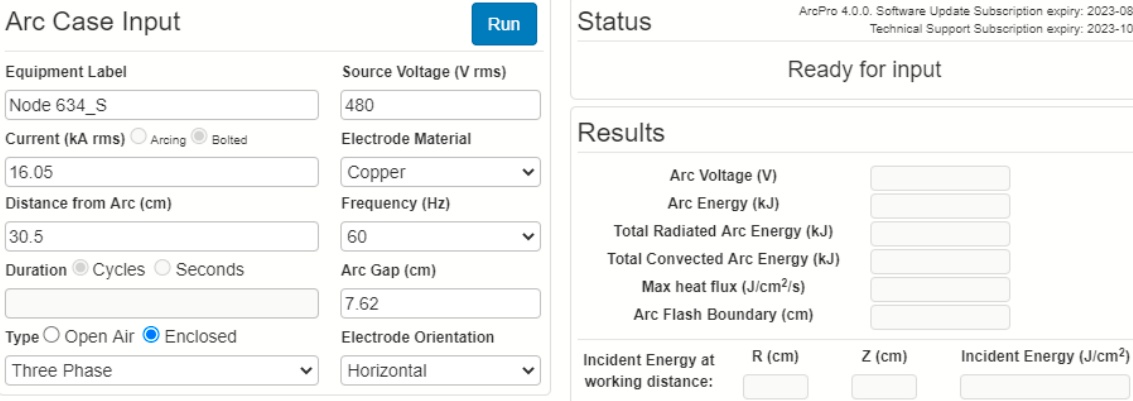
Figure 12. ArcPro simulation results—Case study 4. Table 9. ArcPro simulation results summary—Case study 4. Output